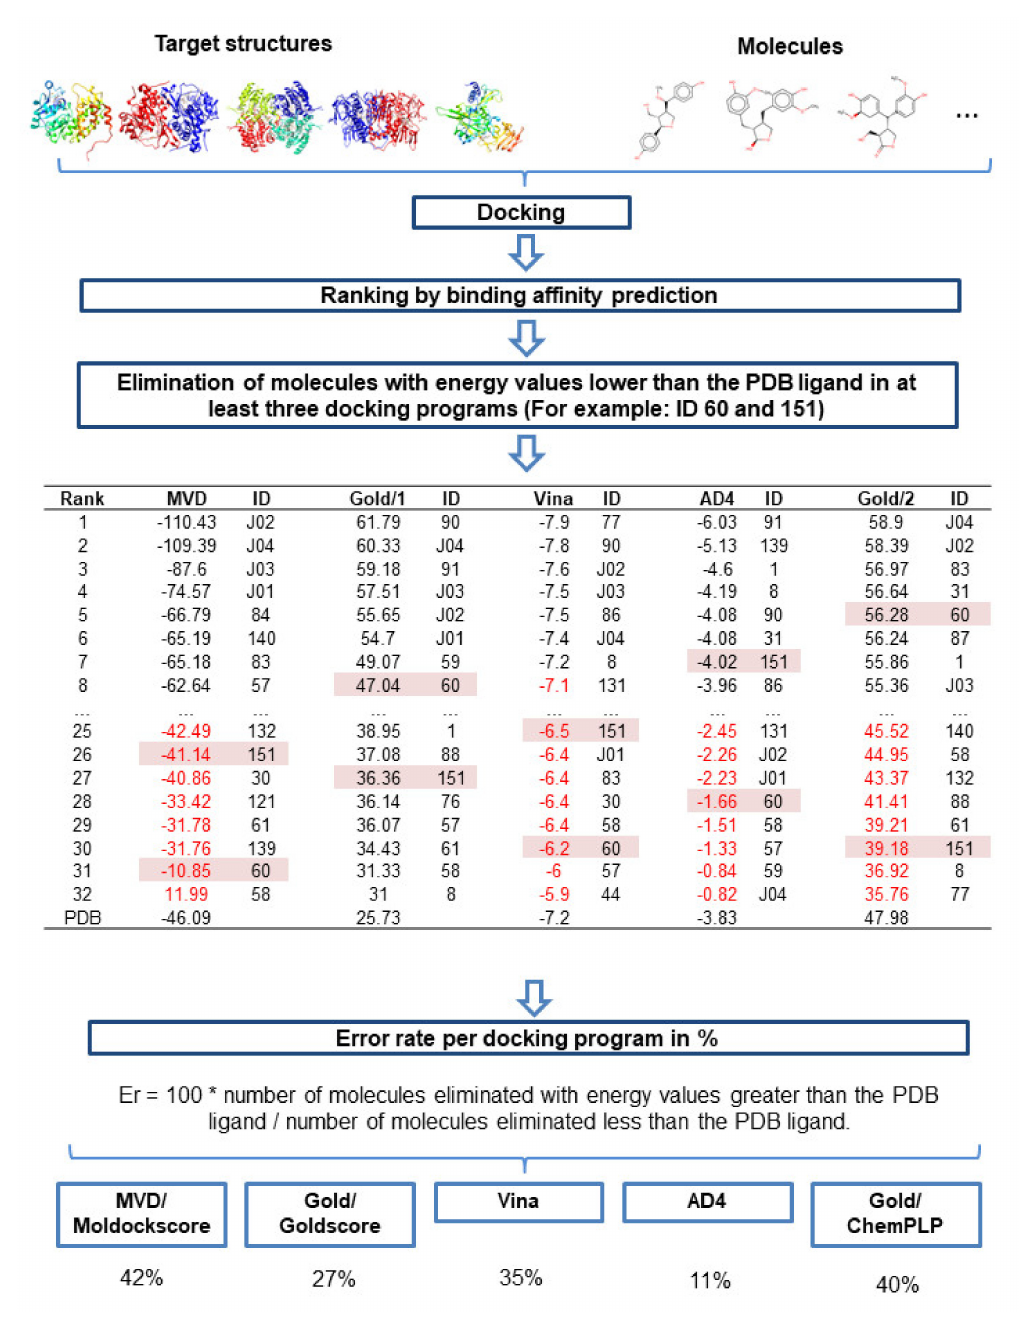
Figure 7. Workflow used to verify the performance of the docking programs, using the connection energy